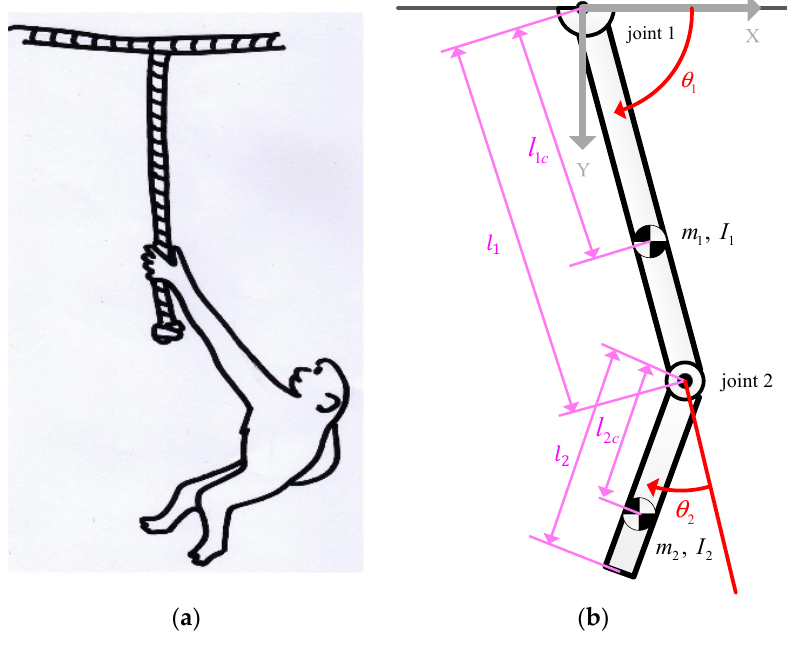
Figure 1. ( a ) A monkey swings in a tree and ( b ) the simplified two-link model.